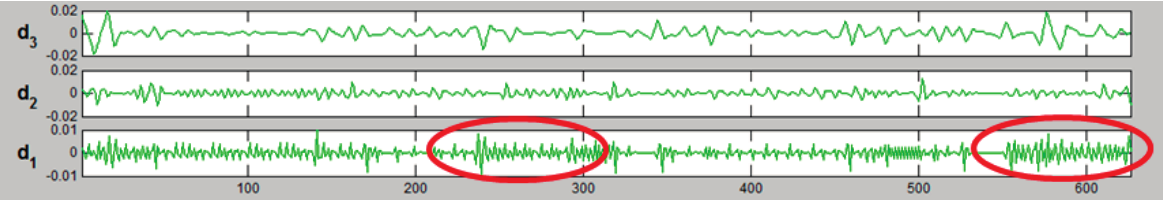
Figure 13. Details of d1, d2 and d3 of ALS signal decomposition, wavelet “sym3”, eight levels.